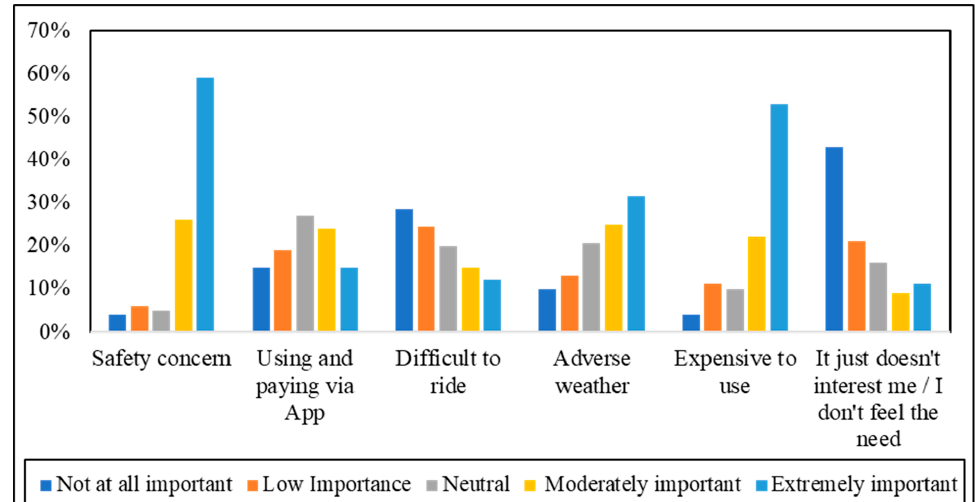
Figure 6. Participants’ opinions about what reasons would prevent them from using the SFFESs.